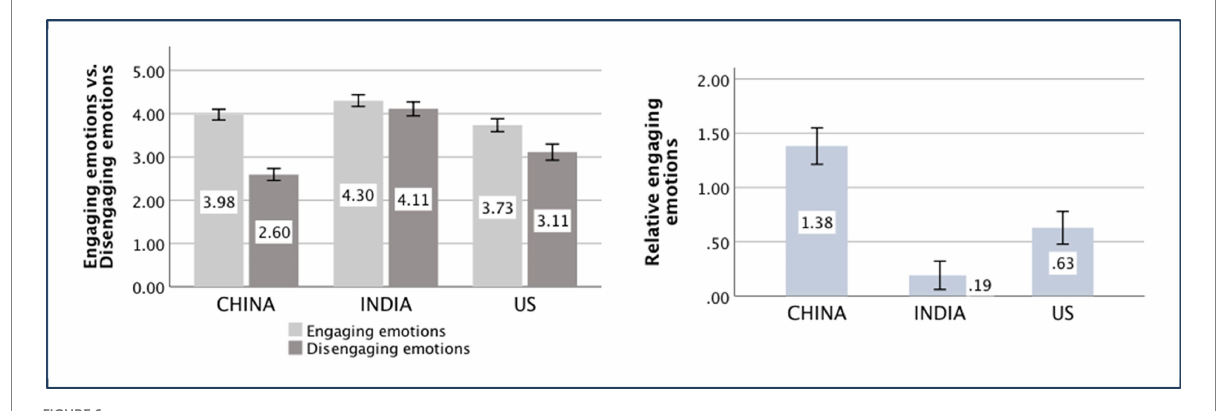
FIGURE 6 Engaging emotions vs. disengaging emotions of China, India, and the United States (US).